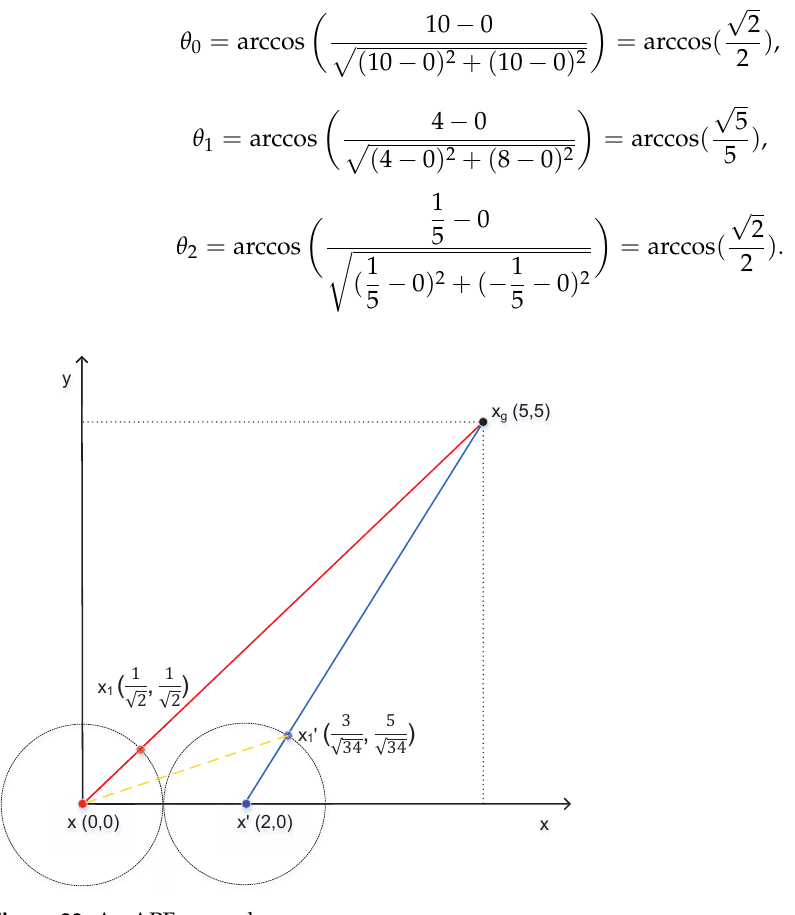
Figure 23. An APF